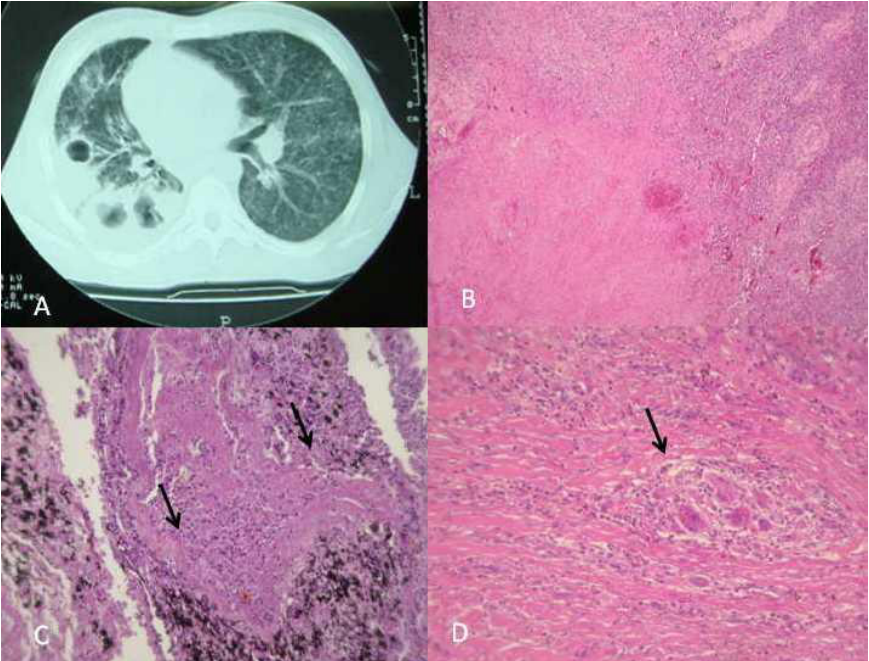
FIGURE 1. (A) CT scan of a patient showing bilateral cavitary masses. (B) Irregular “geographic” basophilic necrosis. (C) Destructive vasculitis (arrows identify remnants of elastic laminae). (D) A granulomatous inflammation with multinucleated giant cells